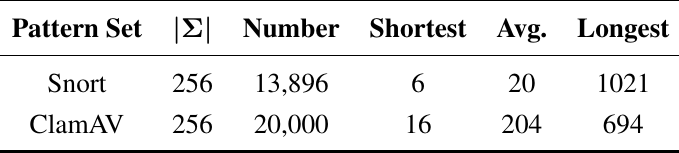
Table 1. Properties of pattern